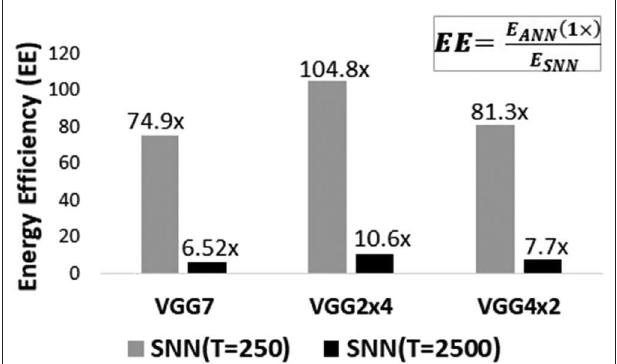
TABLE 5 | Imagenet network topologies for conversion training.